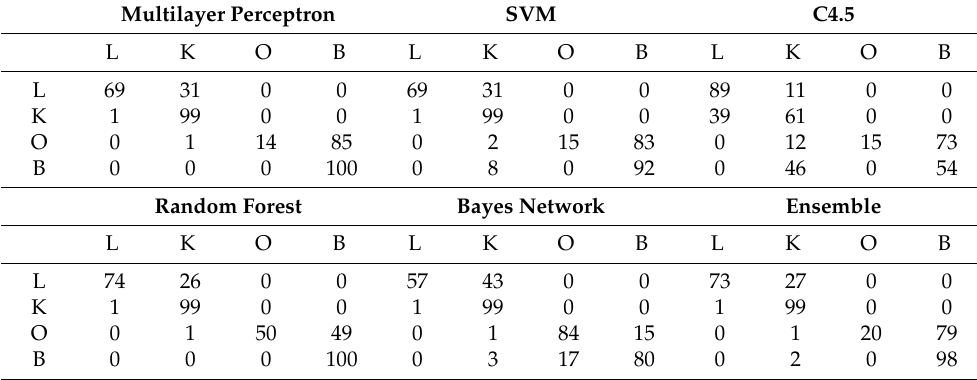
Table 5. Confusion matrix for the first scenario. The samples for training were taken with the user standing up, and moving for testing. The meaning of the capital letters are: L: Living-room, K: Kitchen, O: Office, B: